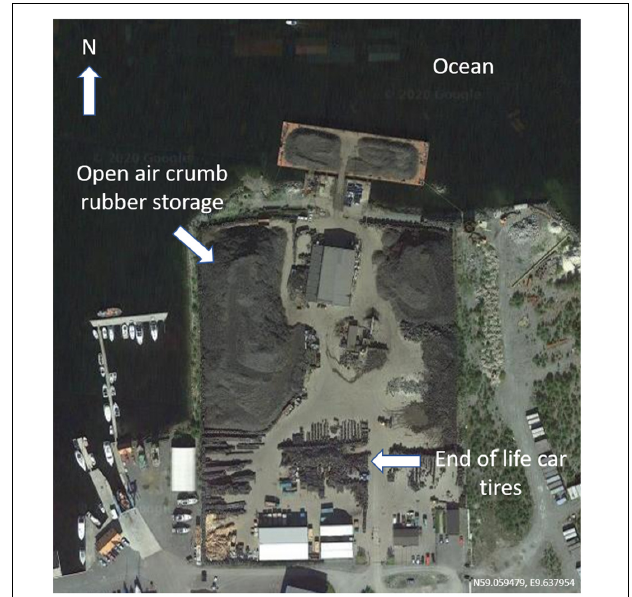
FIGURE 1 | Example of CRG storage and production facilities located adjacent to port and open sea areas near Porsgrunn, Norway. Aerial image generated using Google Maps